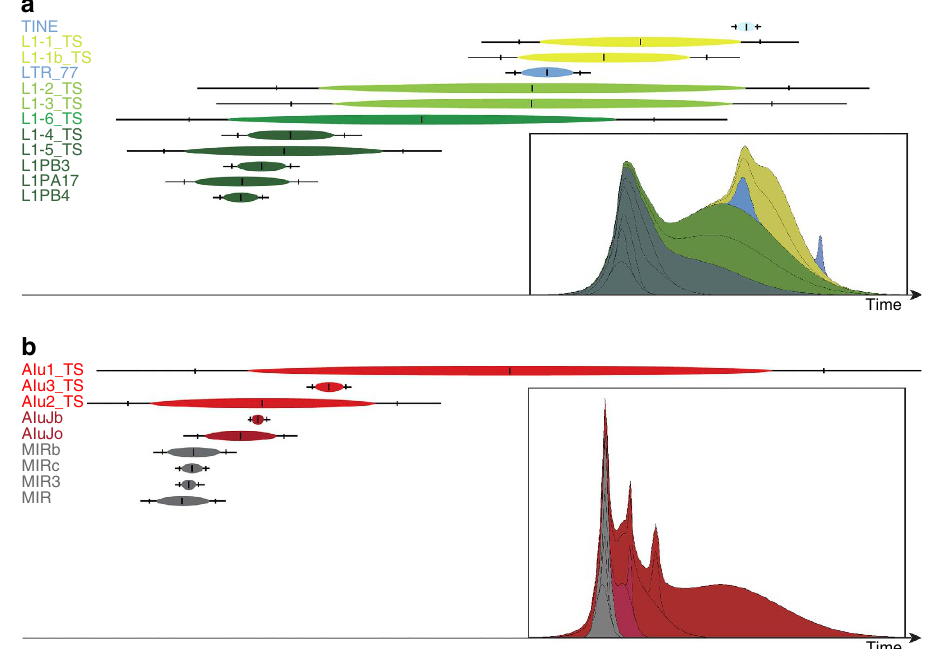
Figure 2 | Transposition in transposition (TinT) patterns of TINEs and SINEs over time. ( a ) Old LINE (L1) elements are displayed in dark green, younger L1s in light green. The TINEs and their proposed LTR_77_TS source gene are depicted in blue. The period of maximal activity is indicated as a central vertical line within the coloured ovals. The flanking vertical lines represent the 75th percentile of the activity range; the terminal lines show the 99th percentile range of activity. The timescale runs from left to right. ( b ) Transposition in Transposition (TinT) pattern of SINE elements, including mammalian-wide interspersed repeats (MIRs; grey), the primate-specific Alu Jb and Alu Jo (dark red), and the tarsier-specific Alu 1-3_TS elements (red). The period of maximal activity is indicated as a central vertical line in the coloured ovals. The flanking vertical lines represent the activity within the 75th percentile range; the terminal lines represent the 99th percentile intervals. The corresponding cumulative likelihoods of element family activity are given as thumbnails in the